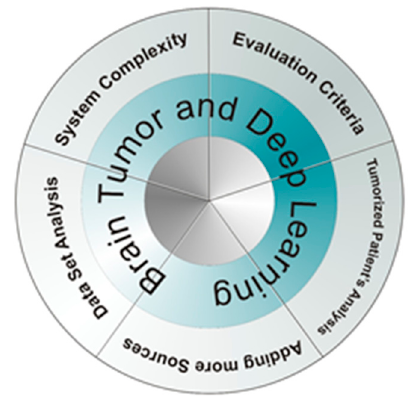
Figure 5. Open Research Challenges in brain tumor